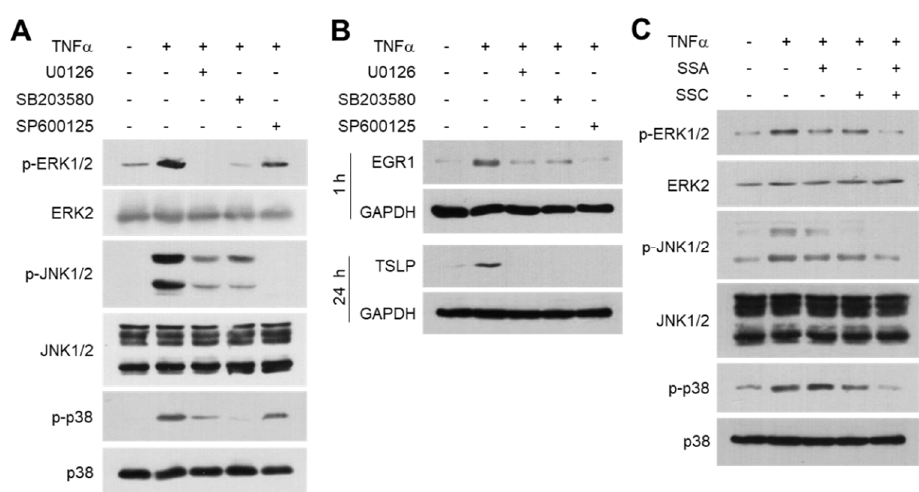
Figure 7. Effects of SSA and SSC on the inhibition of TNF- α -induced mitogen-activated protein kinases (MAPKs). HaCaT cells were pretreated with 10 µM of U0126, 20 µM of SB203580, or 25 µM of SP600125 for 30 min and then treated with 10 ng/mL of TNF- α . ( A ) After 10 min, whole-cell lysates were immunoblotted using phospho-specific and total MAPK antibodies. ( B ) The protein levels of EGR1 (at 1 h) and TSLP (at 24 h) were measured by immunoblotting. ( C ) HaCaT cells were treated with 10 ng/mL of TNF- α for 10 min in the presence or absence of 1 µM SSA or 20 µM SSC. Immunoblotting was performed using phospho-specific and total MAPK antibodies.